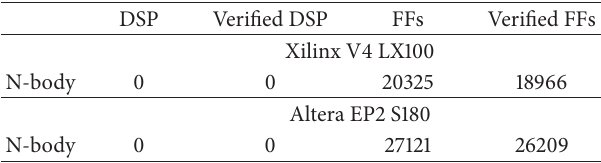
Table 3: Resource utilization (area) prediction for N-body simula-